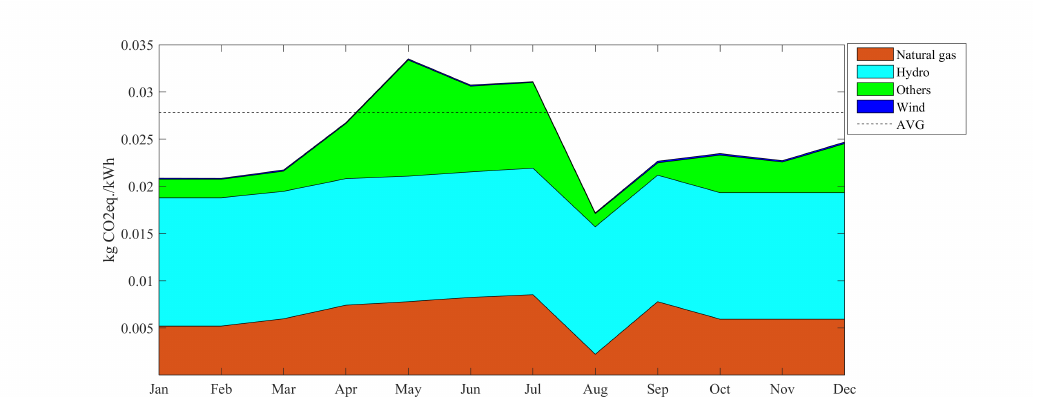
Figure 9. Monthly peak hours GWP compared with average through the year (dotted line) in Norway.